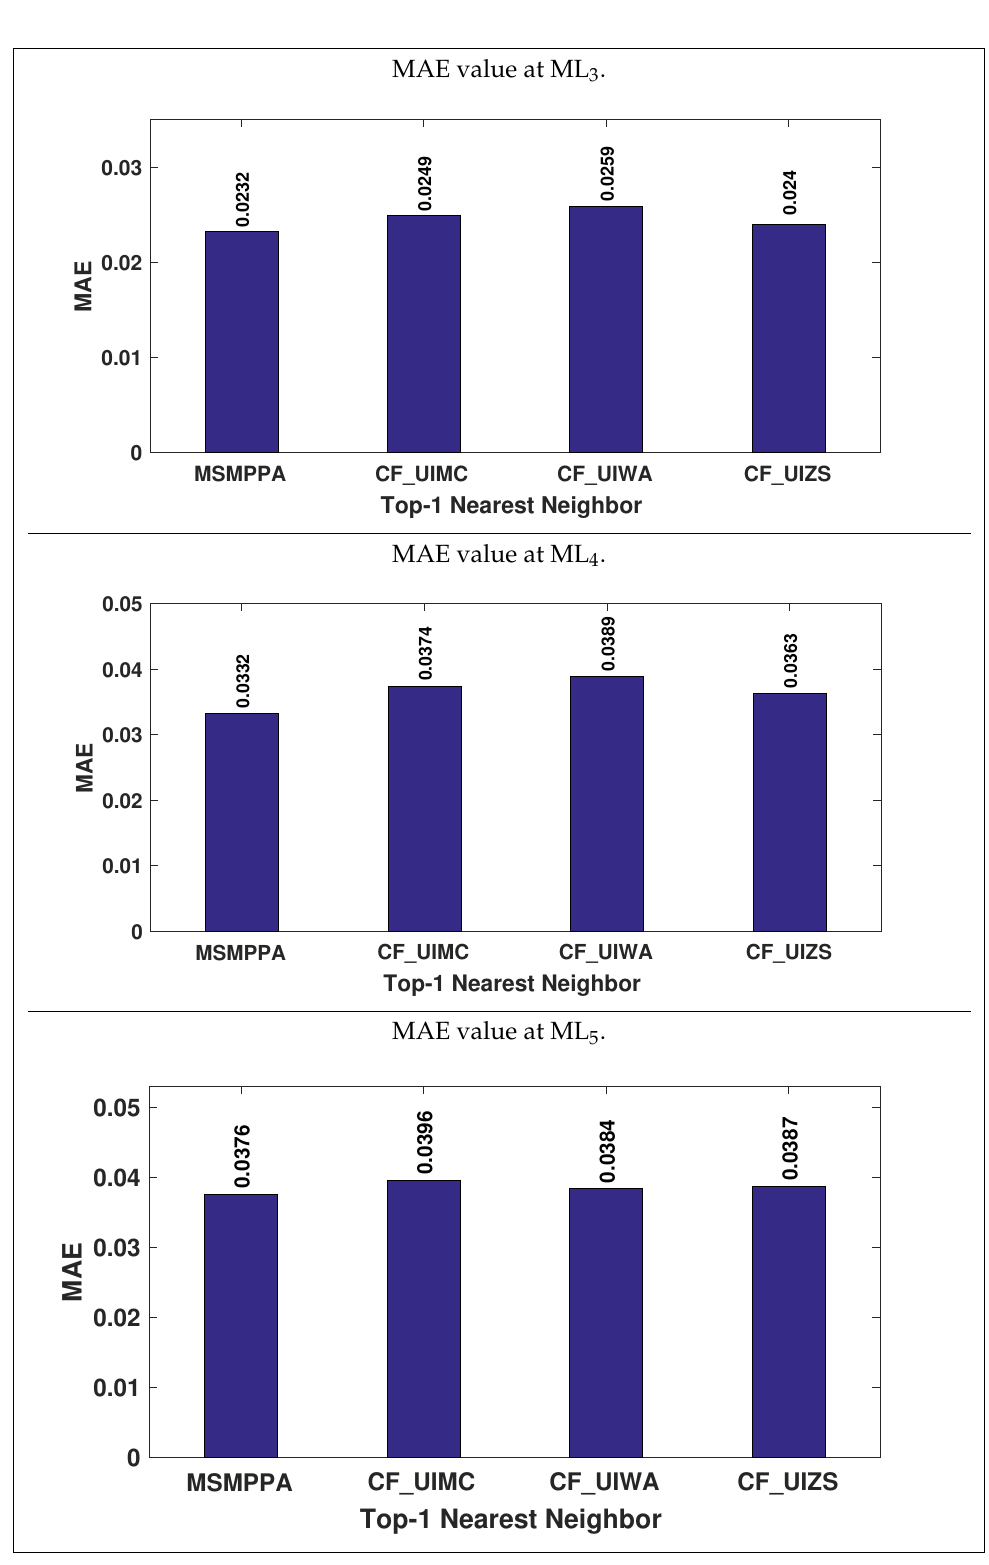
Figure 15. MAE Value at